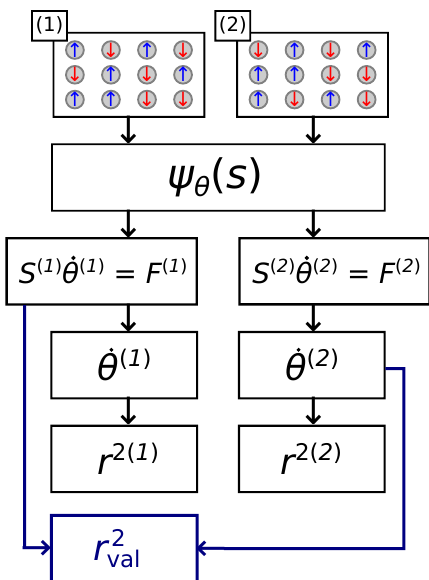
Figure 8: Illustration of the process for computing the validation TDVP error as de- scribed in Sect. 4. Two sets of spin configurations are independently generated via Monte Carlo sampling and used to obtain two independent derivatives through solv- ing the equation of motion. The validation error (15) is then computed as the error of the second update with respect to the first equation of motion.